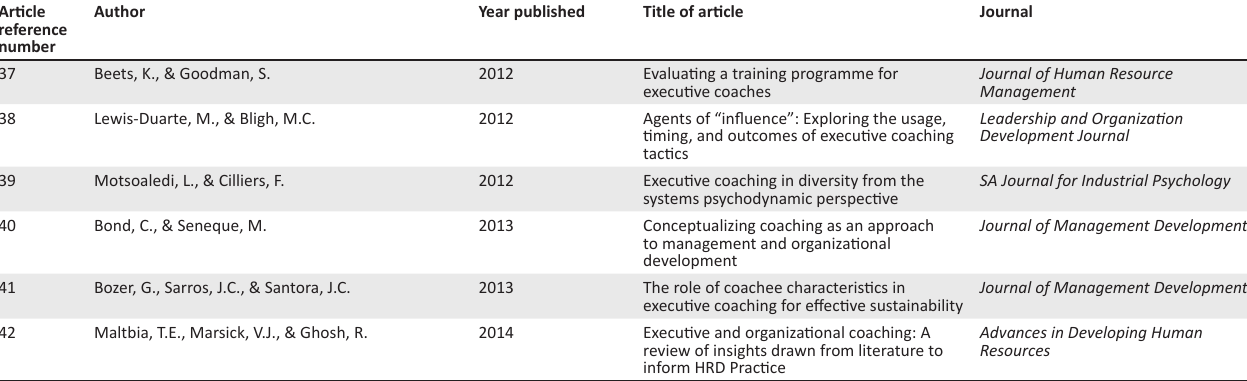
TABLE A1 (Continues...): Chronological list of articles selected for the